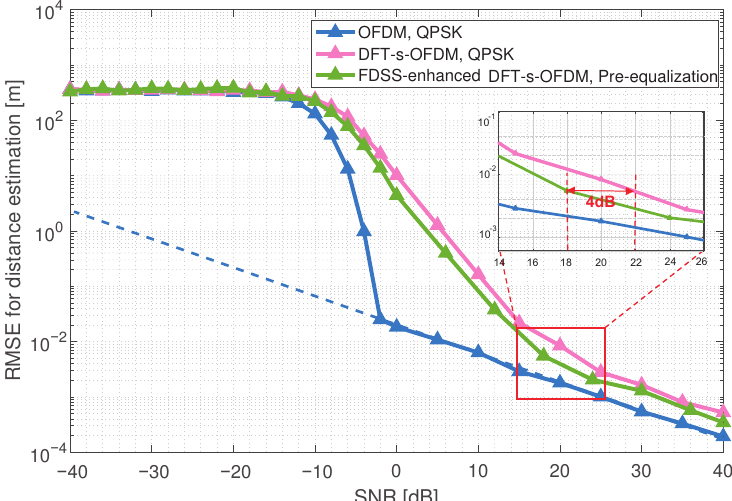
Figure 10. Sensing performance of FDSS-enhanced DFT-s-OFDM with pre-equalization.